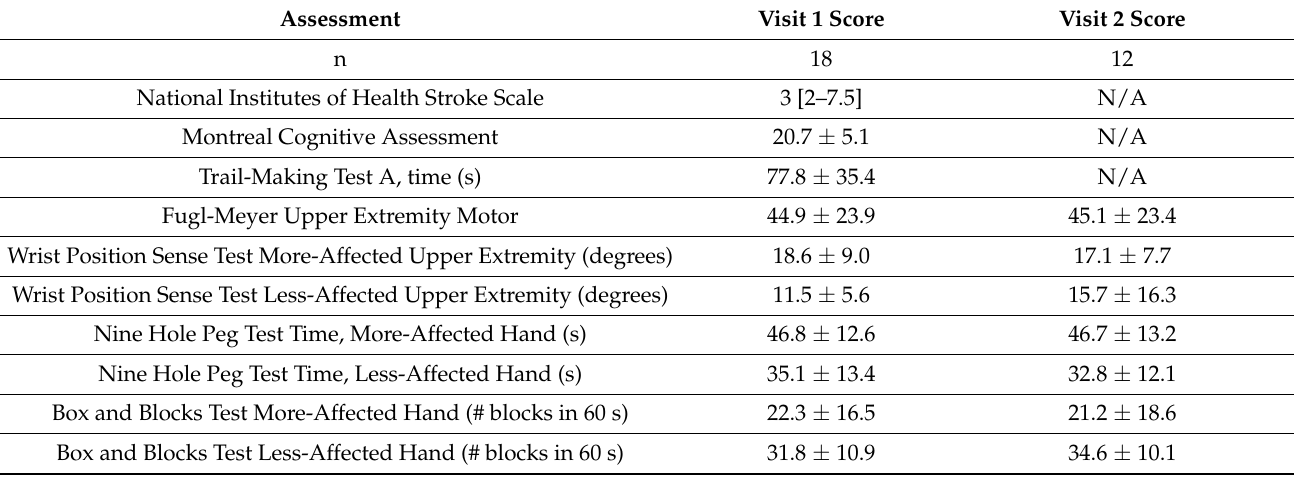
Table 4. Stroke Group